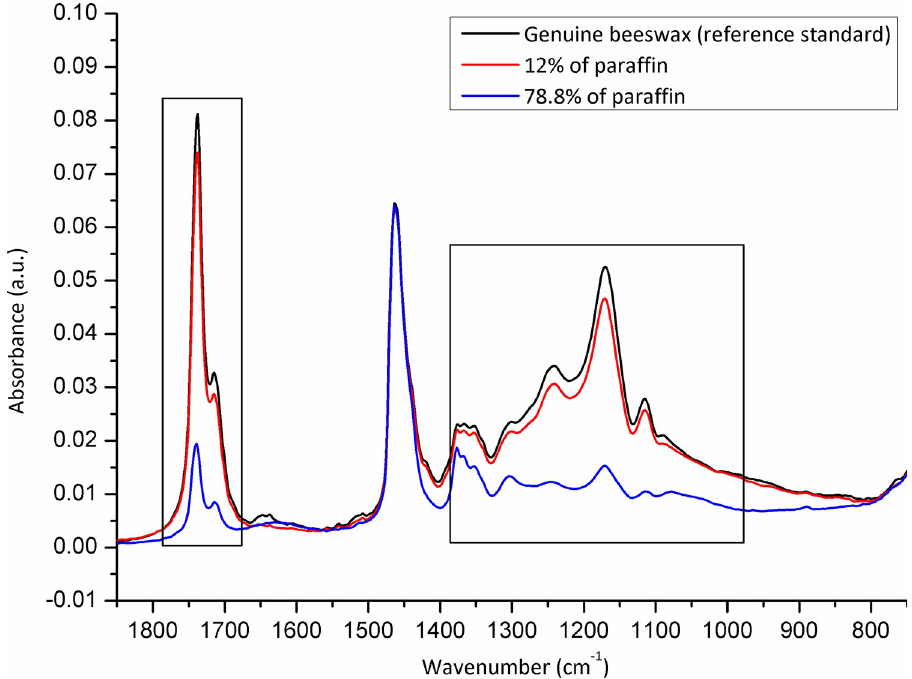
Fig 13. Adulterated beeswax samples versus genuine beeswax (reference standard) with an emphasis on spectral regions indicative for adulteration detection: Paraffin-adulterated beeswax samples. Due to some spectra overlaps (close share of spectra to 2%), only spectra with more than 2% of difference were presented in this figure. Wavenumber, the number of waves per unit distance; cm, centimetre; a.u. is for the absorbance unit.